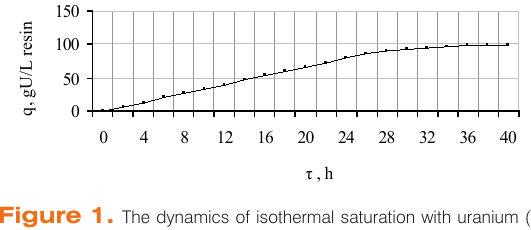
Figure 1. The dynamics of isothermal saturation with uranium (VI) of Purolite resin SG 600 U / 3472 Conditions: i) anions solution composition: U (VI) -0.66 g L -1 ; CO 32- -8.97 g L -1 ; HCO 3- -8.85 g L -1 ; ii) t=20 0 C.